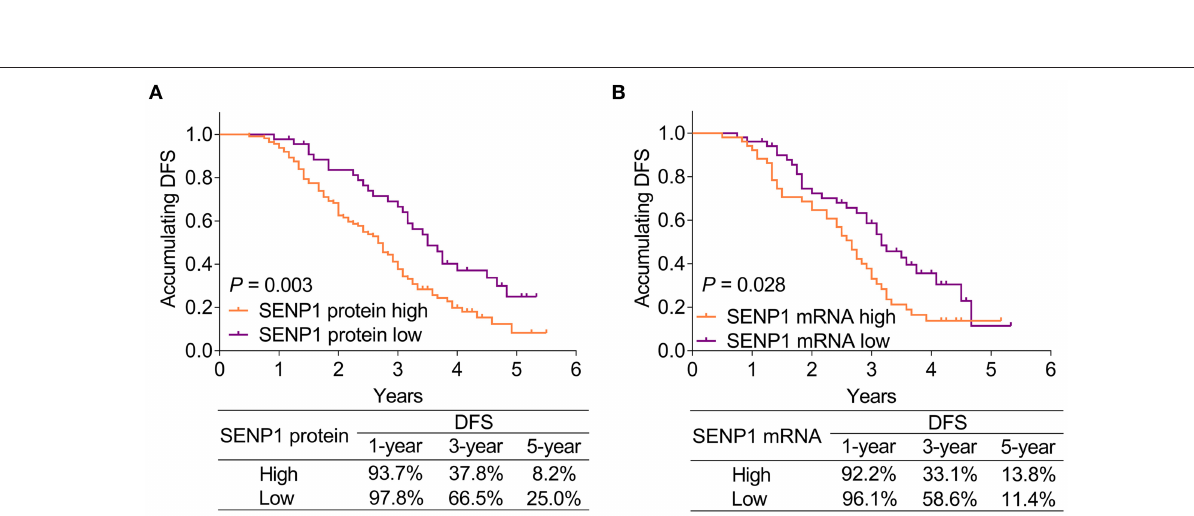
both the SENP1 IHC score ( p = 0.424) and SENP1